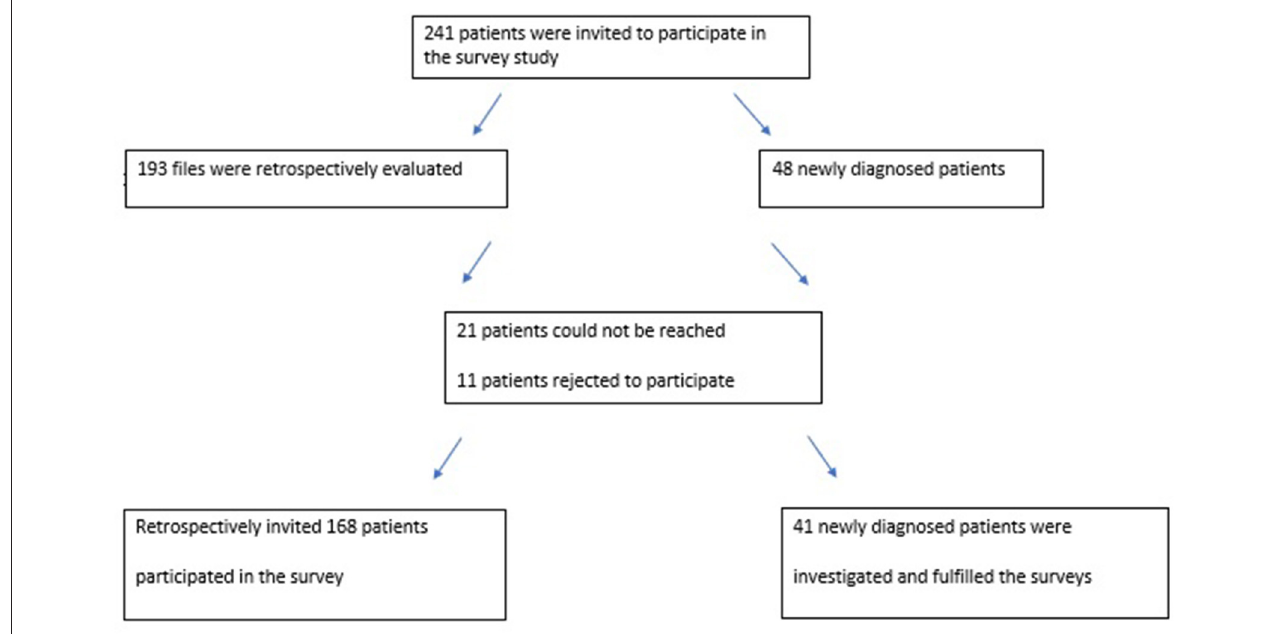
FIGURE 1 | A flow chart of the study design.